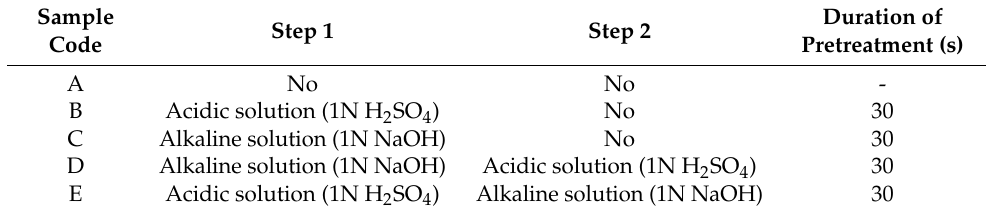
Table 1. Different surface pretreatment applied on AA5083